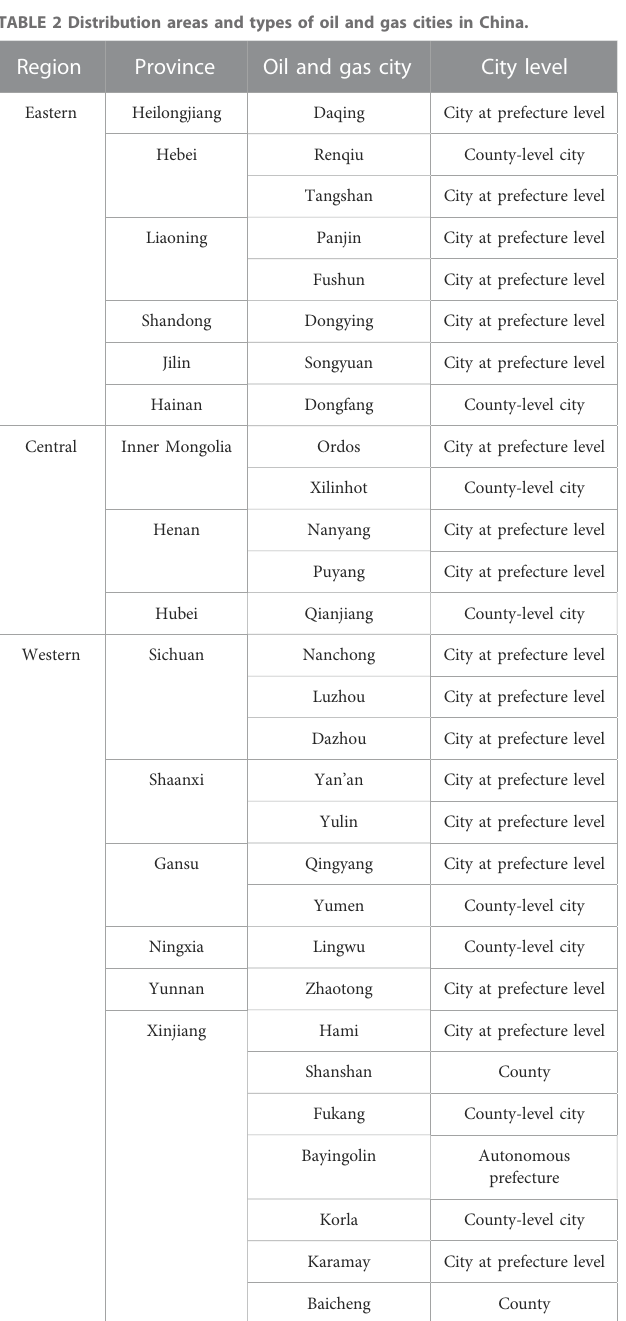
TABLE 1 Evaluation index system of green development ef fi ciency of oil and gas city industry. Type